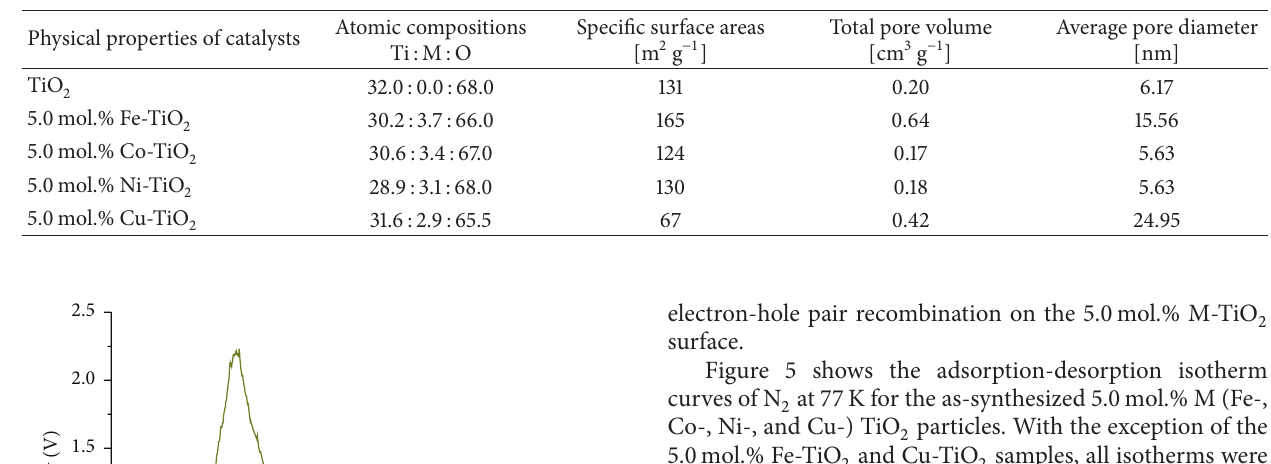
Table 1: Physical properties of 5.0 mol.% M-TiO 2 particles.